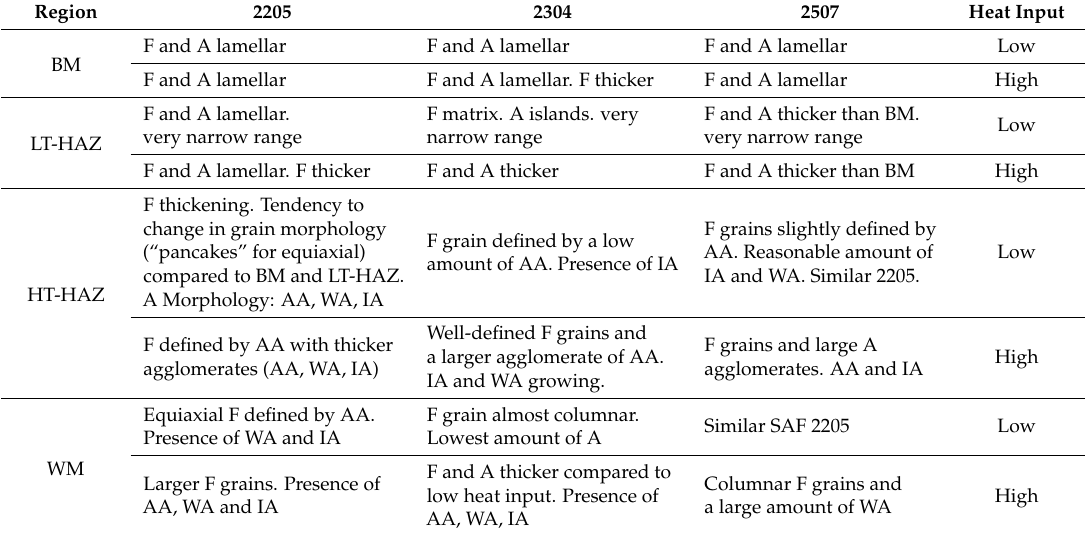
Table 3. Summary of the main microstructural changes for each steel shown in Figures 2–7. A more detailed discussion is found in the text. F—Ferrite; A—Austenite; AA—Allotriomorphic